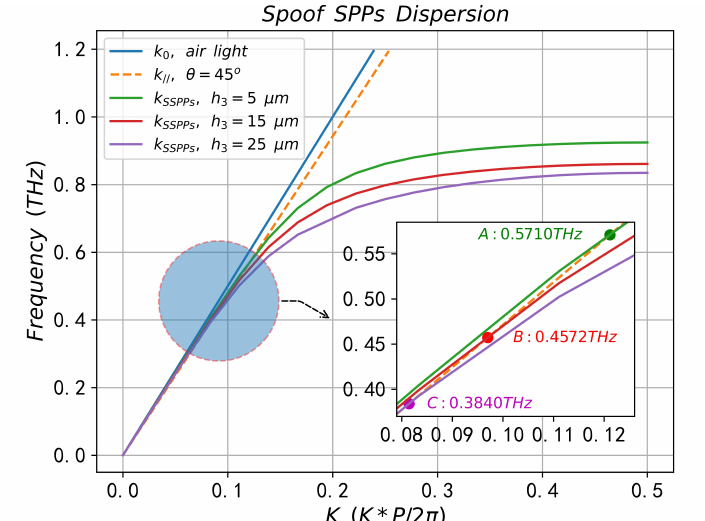
Figure 10. The dispersions of SSPPs with di ff erent sample thicknesses ( h 3 = 5 µ m, 15 µ m, 25 µ m).